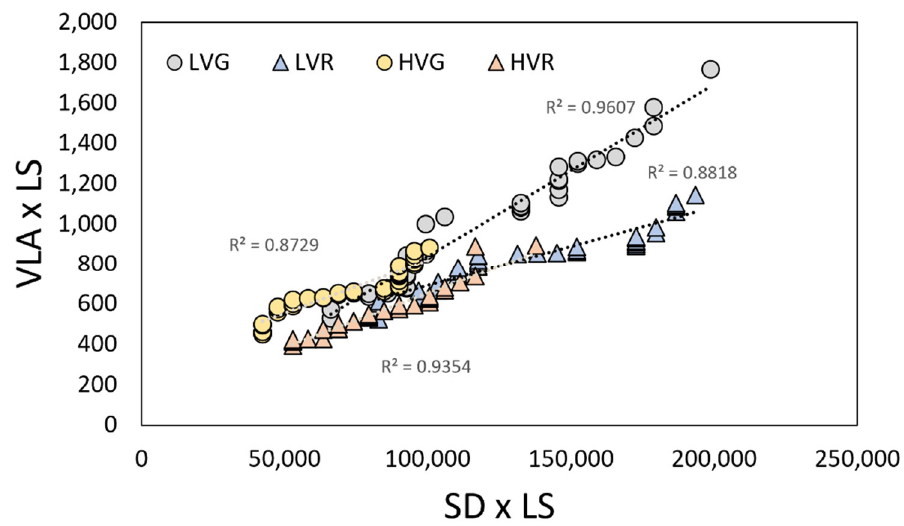
Figure 3. Vein density per leaf size (VLA × LS) and stomatal density per leaf size (SD × LS) of grey (circles) and red (triangles) lettuces grown under low and high VPDs. Regression lines and R2 values are also shown.